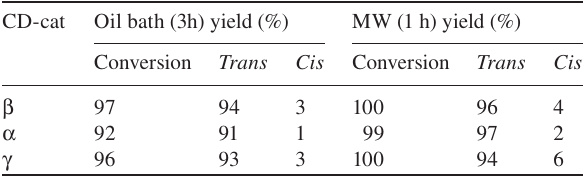
Table 1 Heck reaction with styrene and 4-bromoacetophenone: oil bath vs. MW heating.